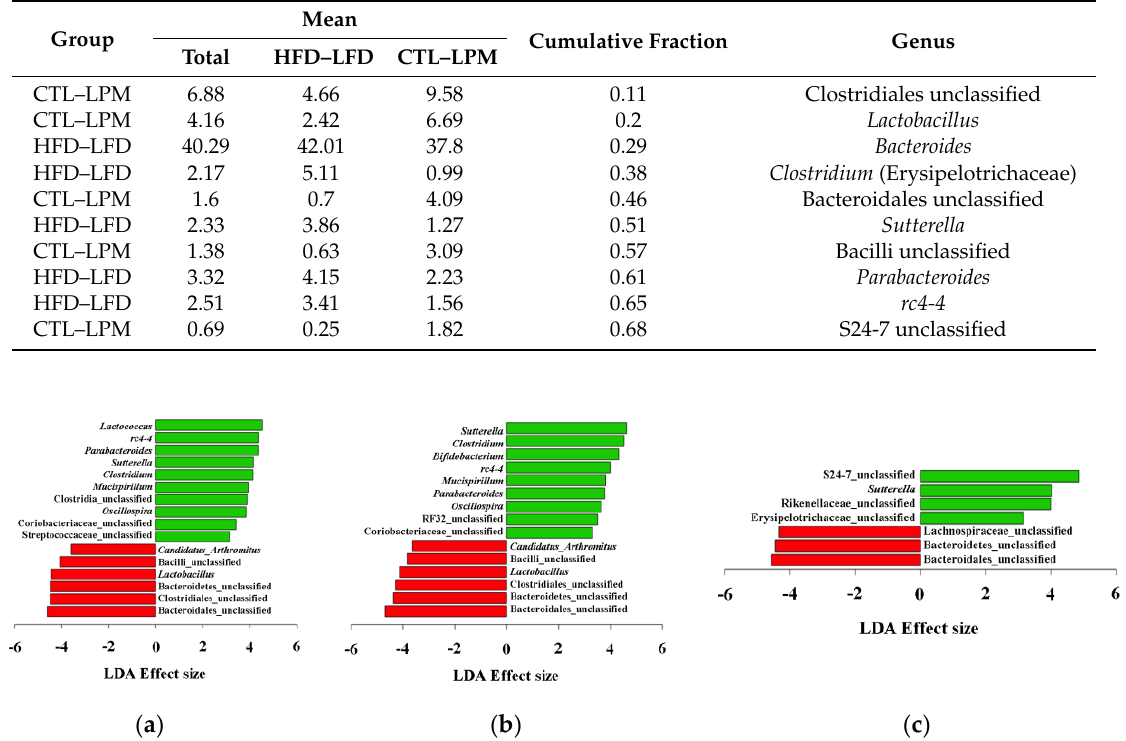
Table 1. Top 10 genera with higher differences in Dirichlet multinomial mixtures analysis.